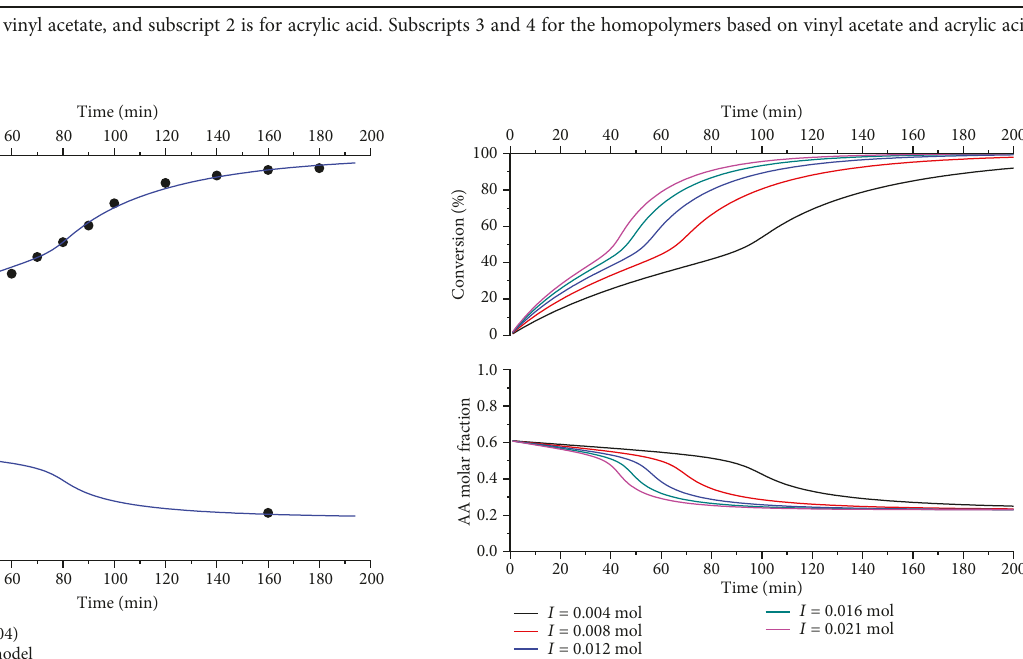
= 1 67 mol, M 1 = 2 927 , r = 0 032 , r 12 21